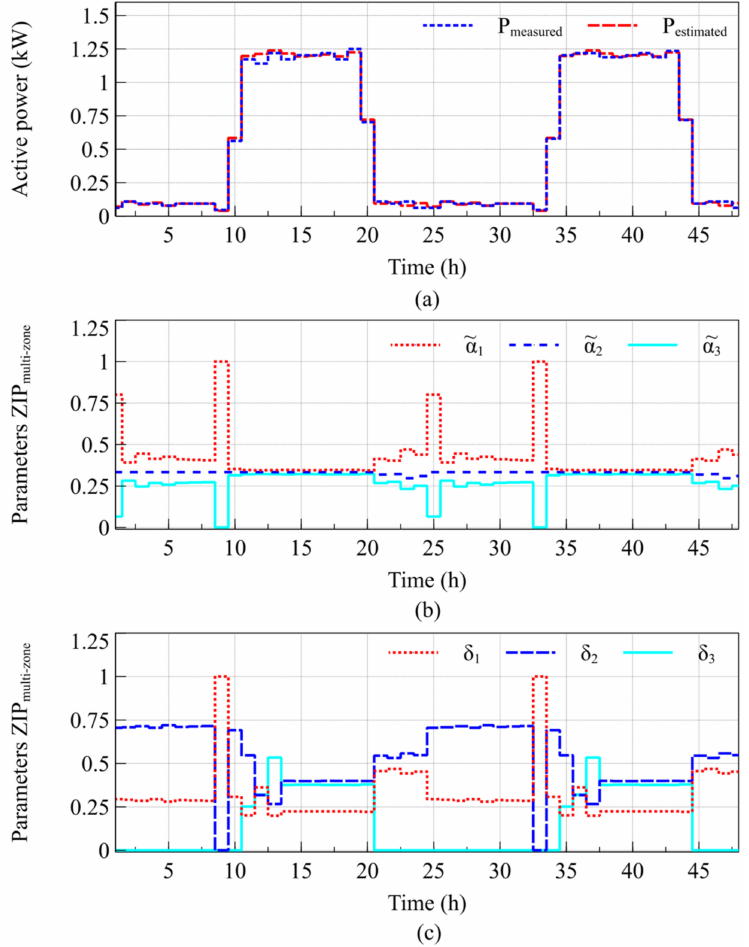
Figure 6. ( a ) Measured and estimated active power, ( b ) evolution of the parameters P 0, agg , k , (cid:101) α 1, k , (cid:101) α 2, k , (cid:101) α 3, k identified using the EMZ-ZIP and ( c ) evolution of the parameters δ 1, k , δ 2, k , δ 3, k identified using the